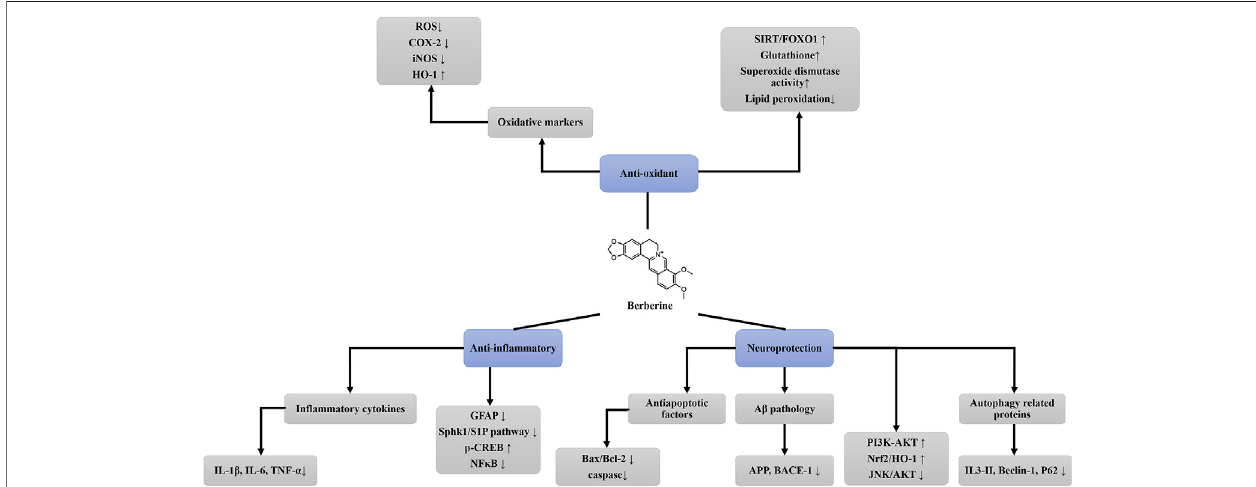
FIGURE 1 | The pharmacological effects of berberine. This schematic drawing shows the anti-oxidant, anti-in fl ammatory and neuroprotective effects of berberine and its related molecular mechanisms. ROS, reactive oxygen species; COX-2, cyclooxygenase-2; iNOS, initric oxide synthase; HO-1, heme oxygenase-1; SIRT1, sirtuin1; FOXO1, forkhead box O1; IL-1 β , interleukin 1 β ; IL-6, interleukin 6; TNF- α , tumor necrosis factor-alpha; GFAP, glial fi brillary acidic protein; SphK1, sphingosine kinase-1; S1P, sphingosine-1-phosphate; p-CREB, phosphorylated cAMP response element binding protein; NF- κ b, nuclear transcription factor kappa B; A β , amyloid β ;APP,amyloidprecursorprotein;BACE1,beta-secretase1;PI3K,phosphatidylinositol3-kinase;AKT,kinase-proteinkinaseB;Nrf2,nuclearfactorerythroid2- related factor-2; JNK, jun amino-terminal